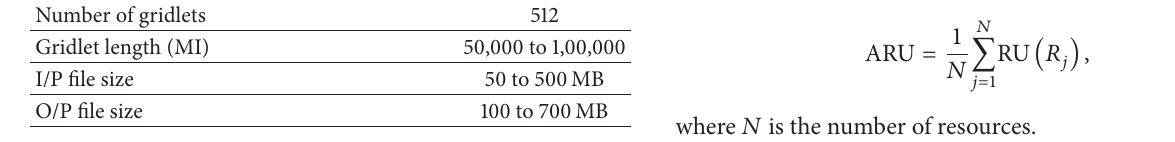
Table 2: Scheduling parameters and their values. Number of